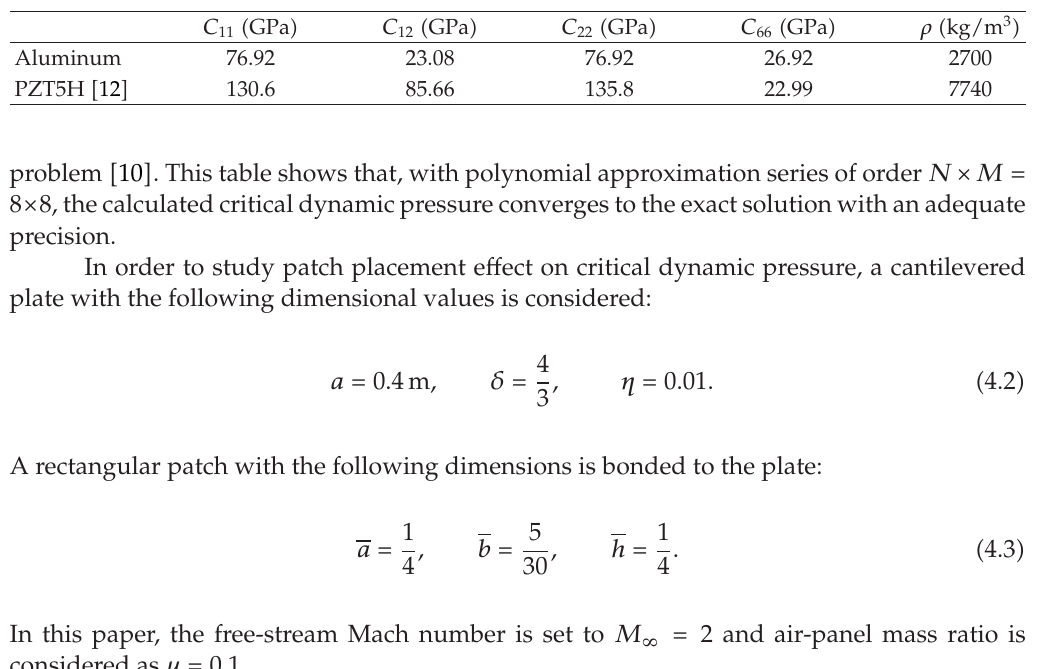
Table 2: Material properties of the base plate and the bonded